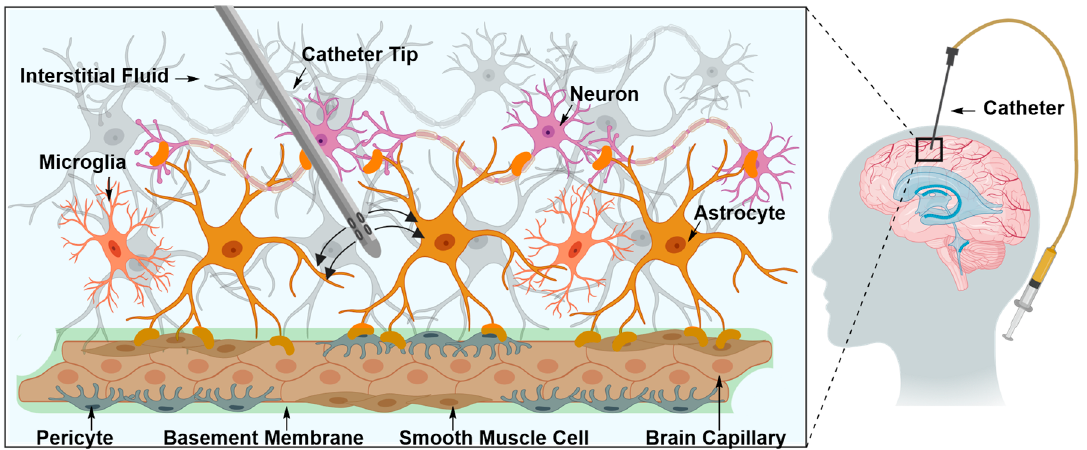
Figure 3. Direct delivery of therapeutic material into the brain interstitial space using a specialized catheter. The interstitial space is occupied with interstitial fluid (ISF). Directly injected therapeutic material diffuses through the ISF and accesses different regions of brain parenchyma.